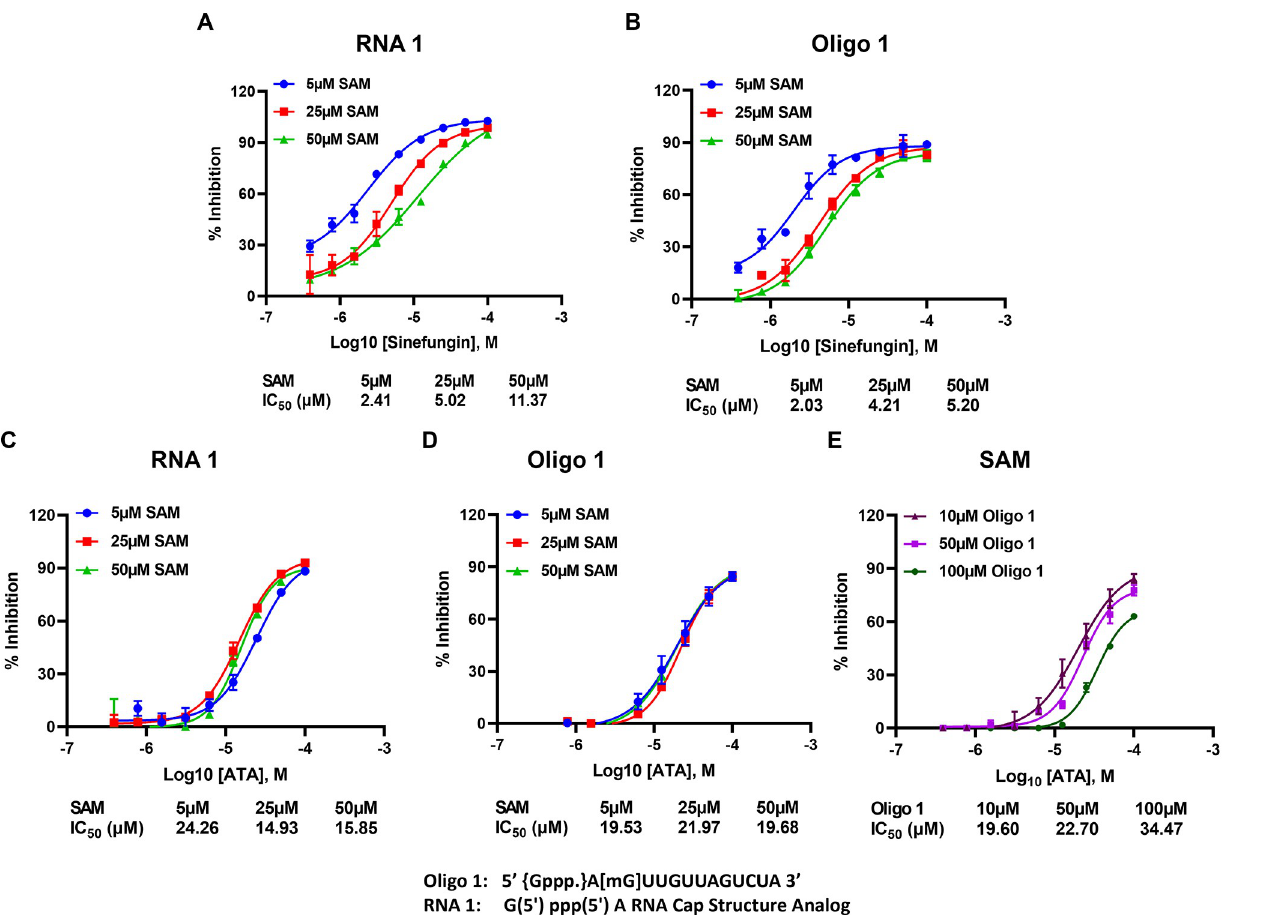
Fig 7. SARS-CoV-2 NSP14 MTase inhibitors study. Effect of sinefungin concentrations on nsp14 (1ng) MTase activity at different concentrations of SAM (5 μ M, 25 μ M, and 50 μ M) using 10 μ M of RNA 1 (A) or 10 μ M of Oligo1 (B). Effect of Aurintricarboxylic acid (ATA) on the activity of nsp14 (1ng) in the presence of varying concentrations of SAM (5 μ M,25 μ M, and 50 μ M) using 10 μ M RNA1 (C), or 10 μ M Oligo1 (D) and varying concentrations of Oligo1 (10 μ M,50 μ M,100 μ M) at 5 μ M SAM (E). Reactions were carried out for 90min at 37˚C. All reactions were done using a white solid 384LV-well plate, and The MTase-Glo ™ Assay was performed as described in Materials and Methods section. Each point represents an average of two data points; the error bars represent the standard deviation. Data analysis was performed with GraphPad Prism 1 software, version 9.1.0, for Windows 1 using a Sigmoidal dose response (variable slope)